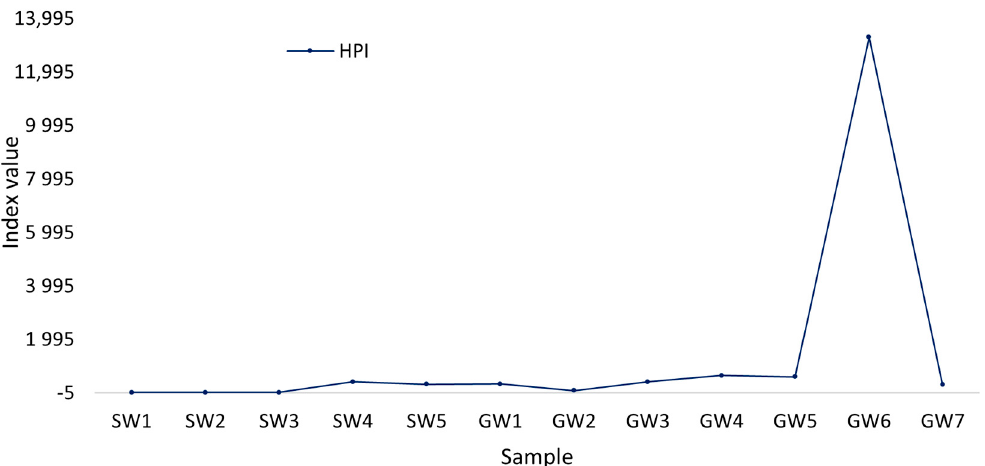
Figure 10. HPI samples studied.